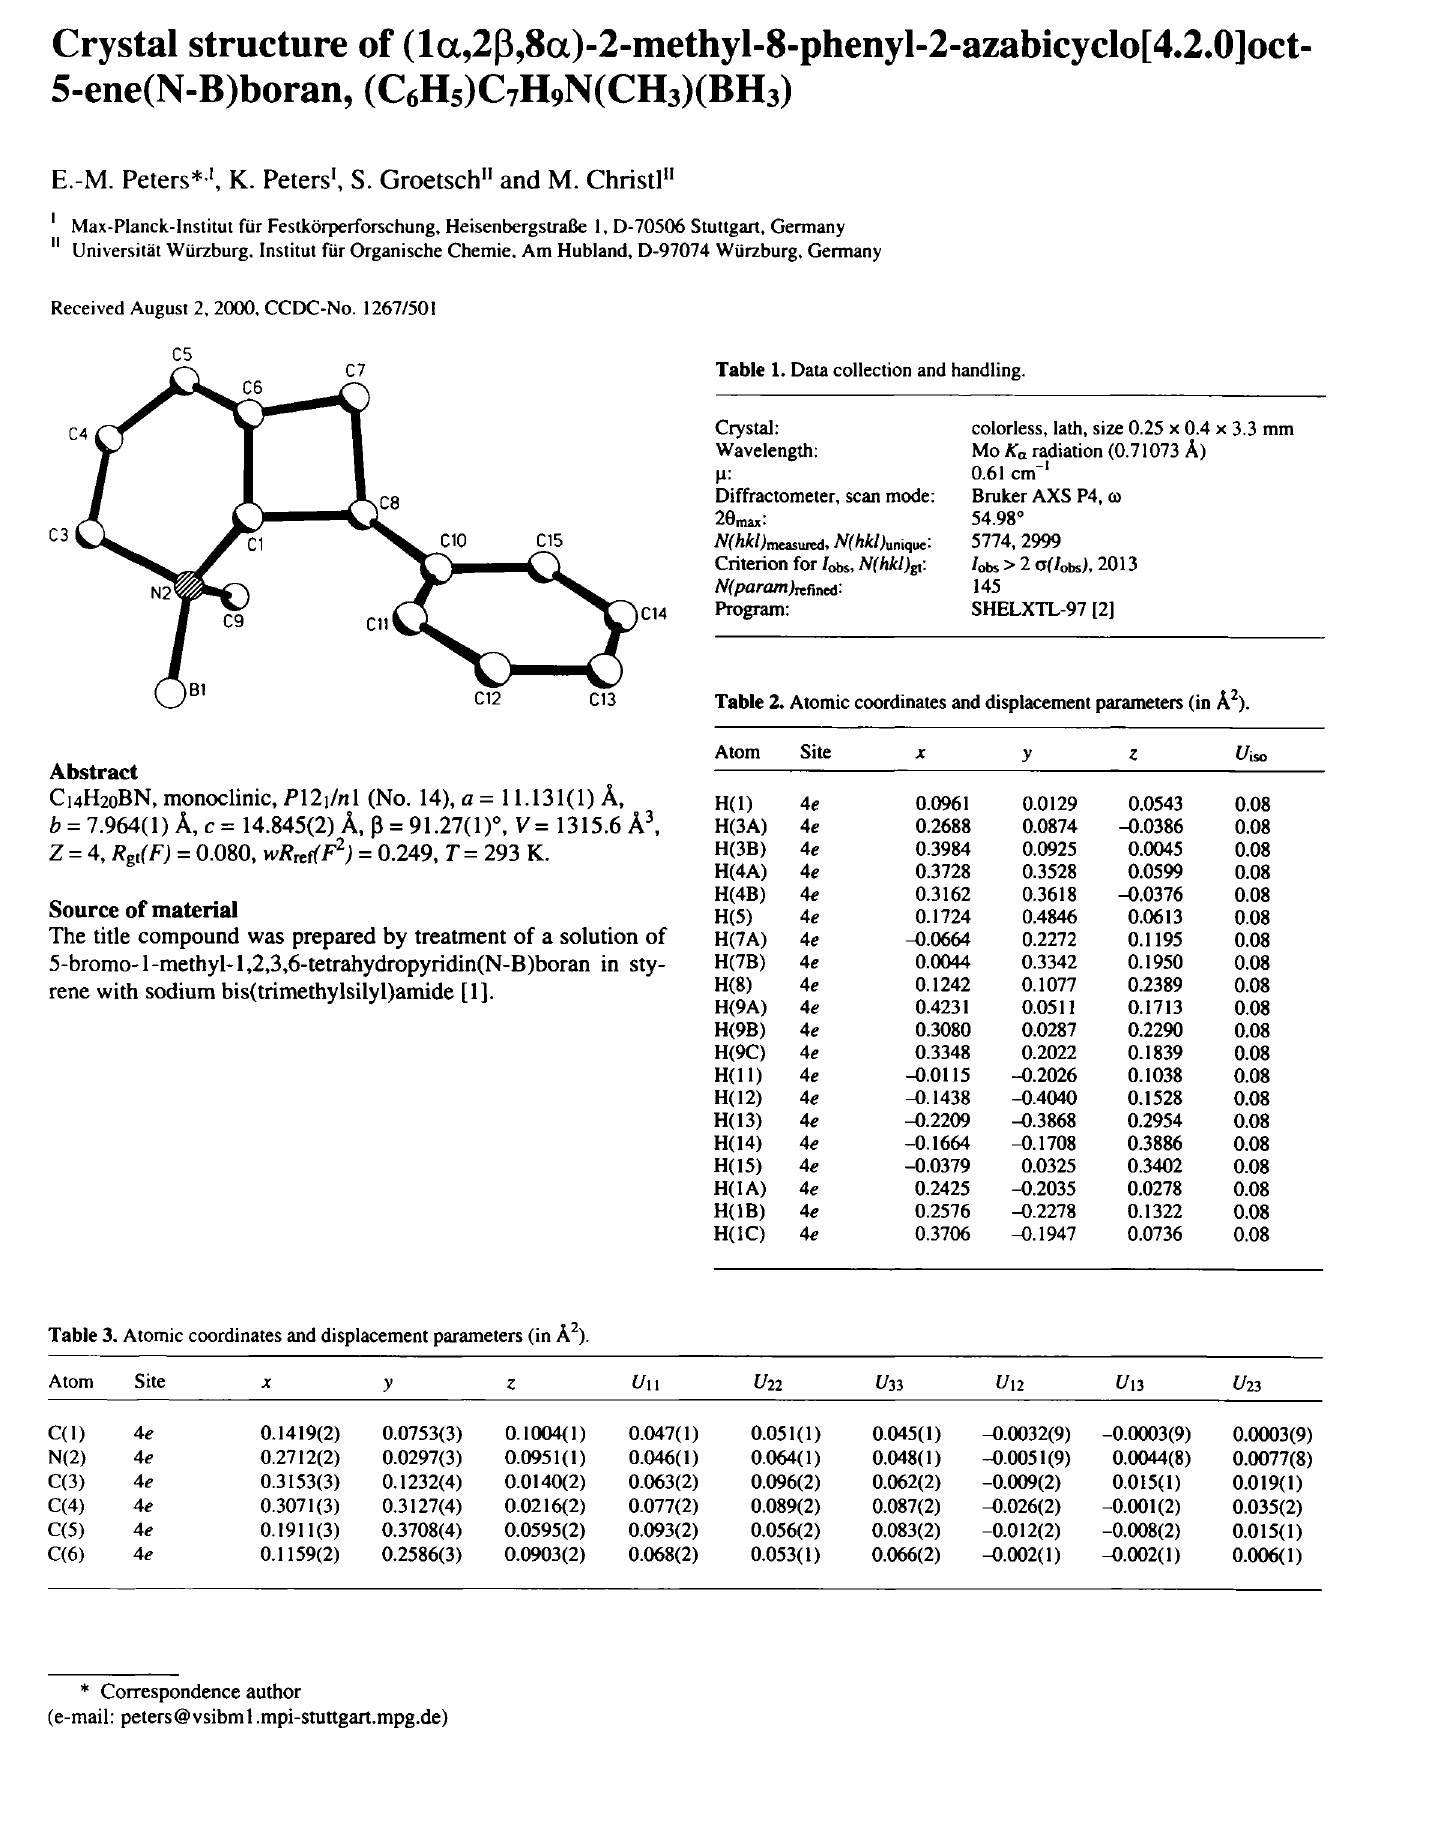
Table 1. Data collection and handling.